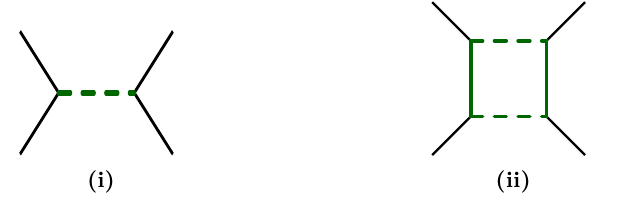
Figure 8 . (i) Tree- and (ii) one-loop-level diagrams built of Lorentz invariant renormalizable interactions of the UV theory that lead to effective operators of ψ 4 class.